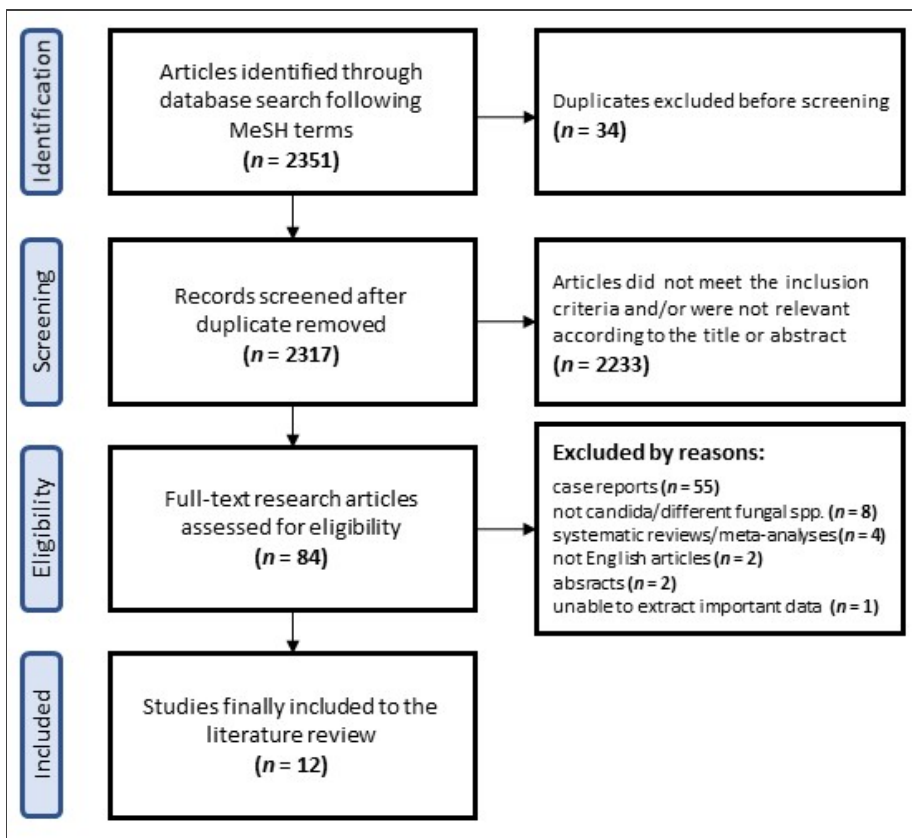
Figure 1. PRISMA (Preferred Reported Item for Systematic review and Meta-Analysis) flow diagram of the articles extracted from the electronic databases following the key MeSH terms.